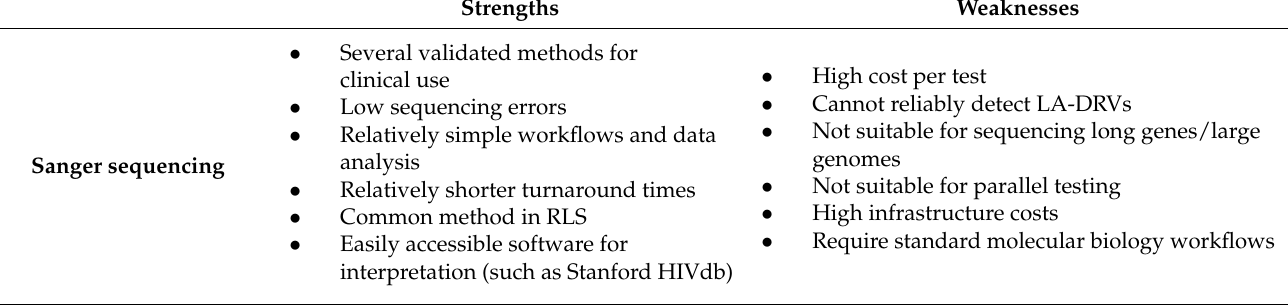
Table 3. Strengths and limitations of Sanger sequencing and NGS in HIVDR genotyping methods. Strengths Weaknesses